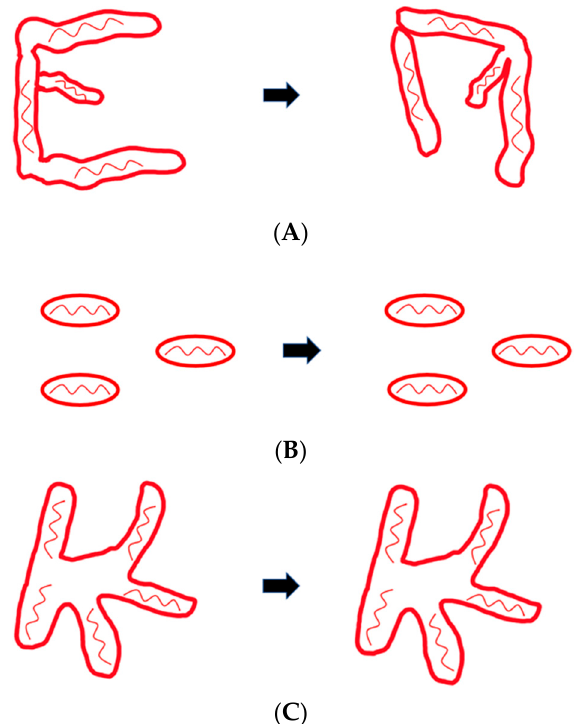
Figure 2. Changes in mitochondrial dynamics when fission or fusion is inhibited. ( A ) Dynamics in normal healthy cells shows how the mitochondrial network changes. ( B ) In the absence of fusion, motility is inhibited, thus, over time, mitochondrial distribution undergoes little change. ( C ) In the absence of fission, the mitochondrial network becomes too large and motility is inhibited. This again results in a similar distribution of the mitochondria over